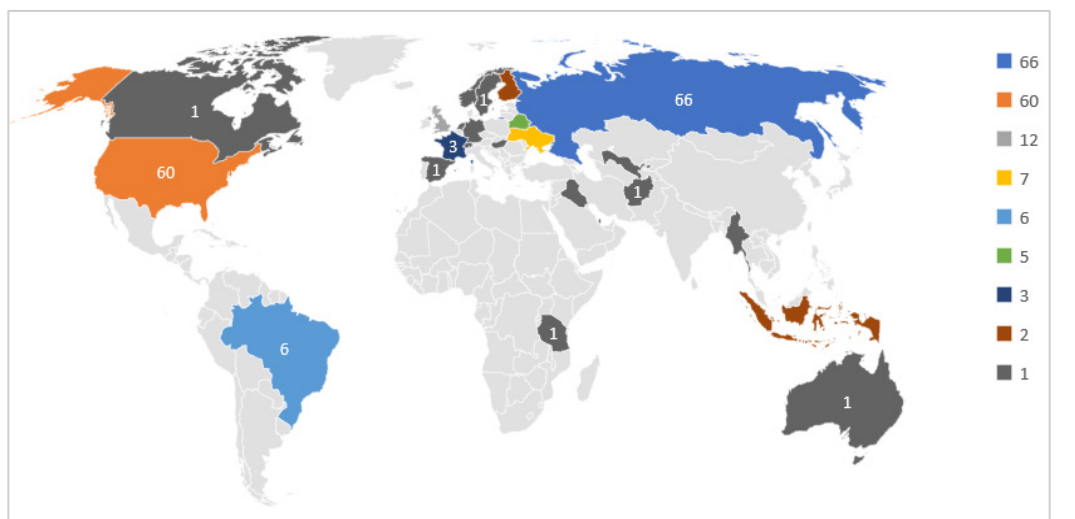
Figure 2. Participants Geographical Distribution.